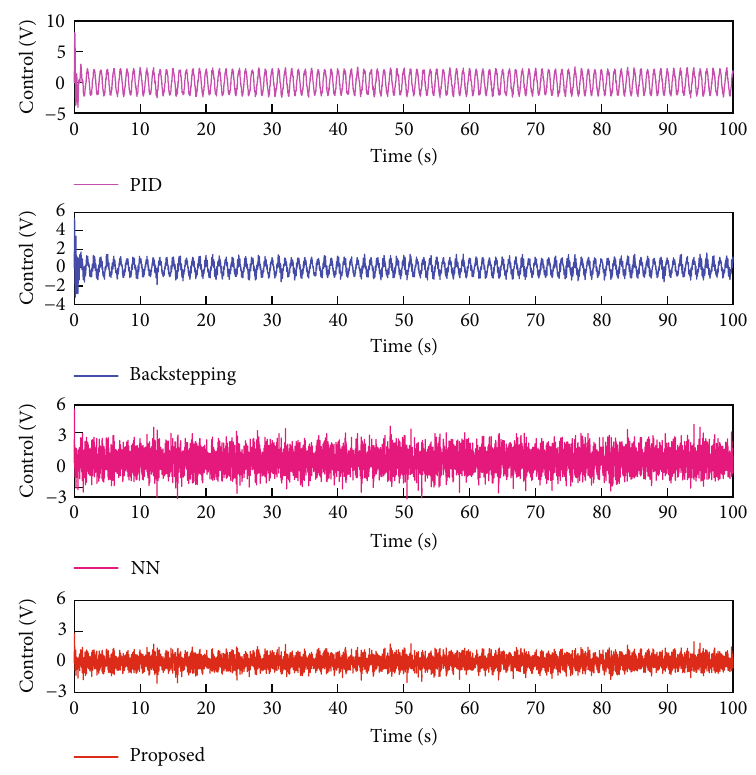
Figure 10: Control signal of sine